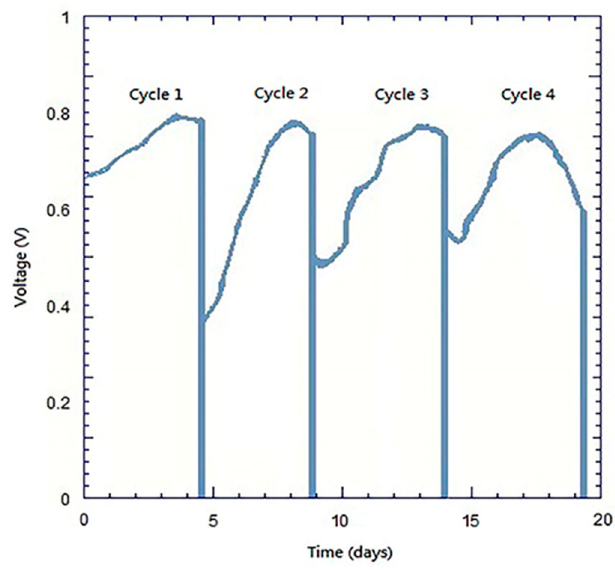
Figure 10. Plot of discharge voltage vs. time for FePc/CNT/SS316.